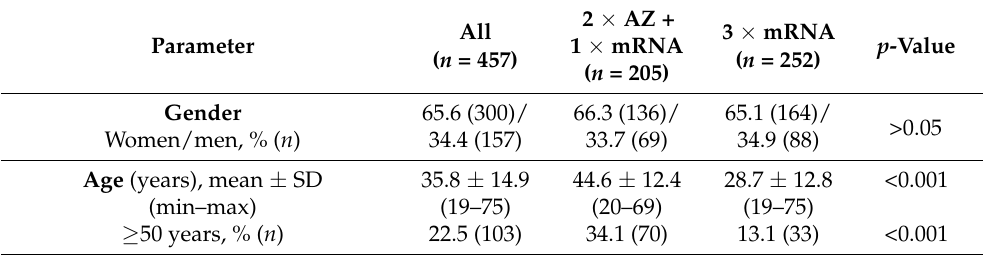
Table 1. The demographic characteristics of the studied groups of vaccinated